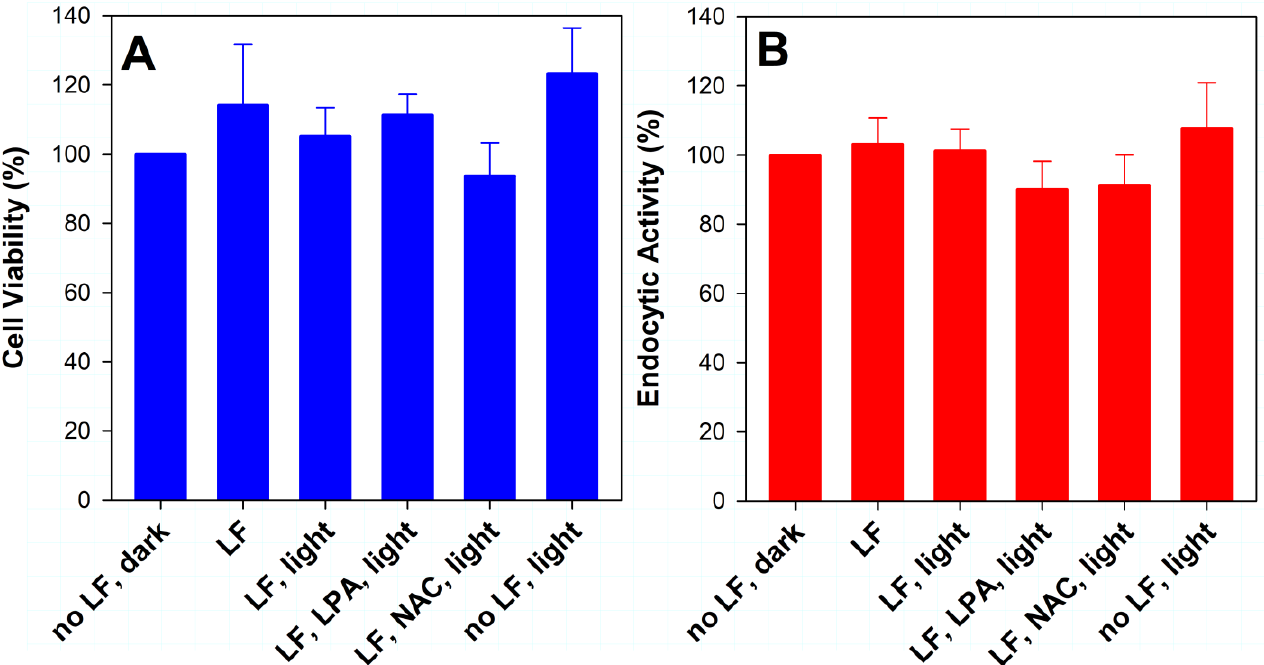
Figure 7. Lipofuscin and/or fractionated exposure to 9.76 mW/cm 2 visible light does not affect via- bility or endocytic activity of ARPE-19 cells. ( A ) Cell viability measured by MTT assay. ( B ) Endocytic activity was measured by neutral red assay. Confluent cells were supplemented with lipofuscin (LF) or sham-treated (no LF) for 32 days followed by 15 days with 14 daily media changes and 45 min incubations with PBS in dark (dark) or 14 daily media changes and 45 min exposures to 9.76 mJ/cm 2 visible light (light). Cells in selected wells were exposed to light in the presence of 0.1 mM lipoic acid (LPA) or 0.2 mM N-acetyl cysteine (NAC). The assays were performed a day after the 14th exposure to light/dark. The absorbance values were normalized to the value obtained in cells not supplemented with lipofuscin and maintained in dark. The height of the bar indicates the mean of three experiments, while the error bar indicates SD. One-way analysis of variance (ANOVA) showed no significant differences between any groups.